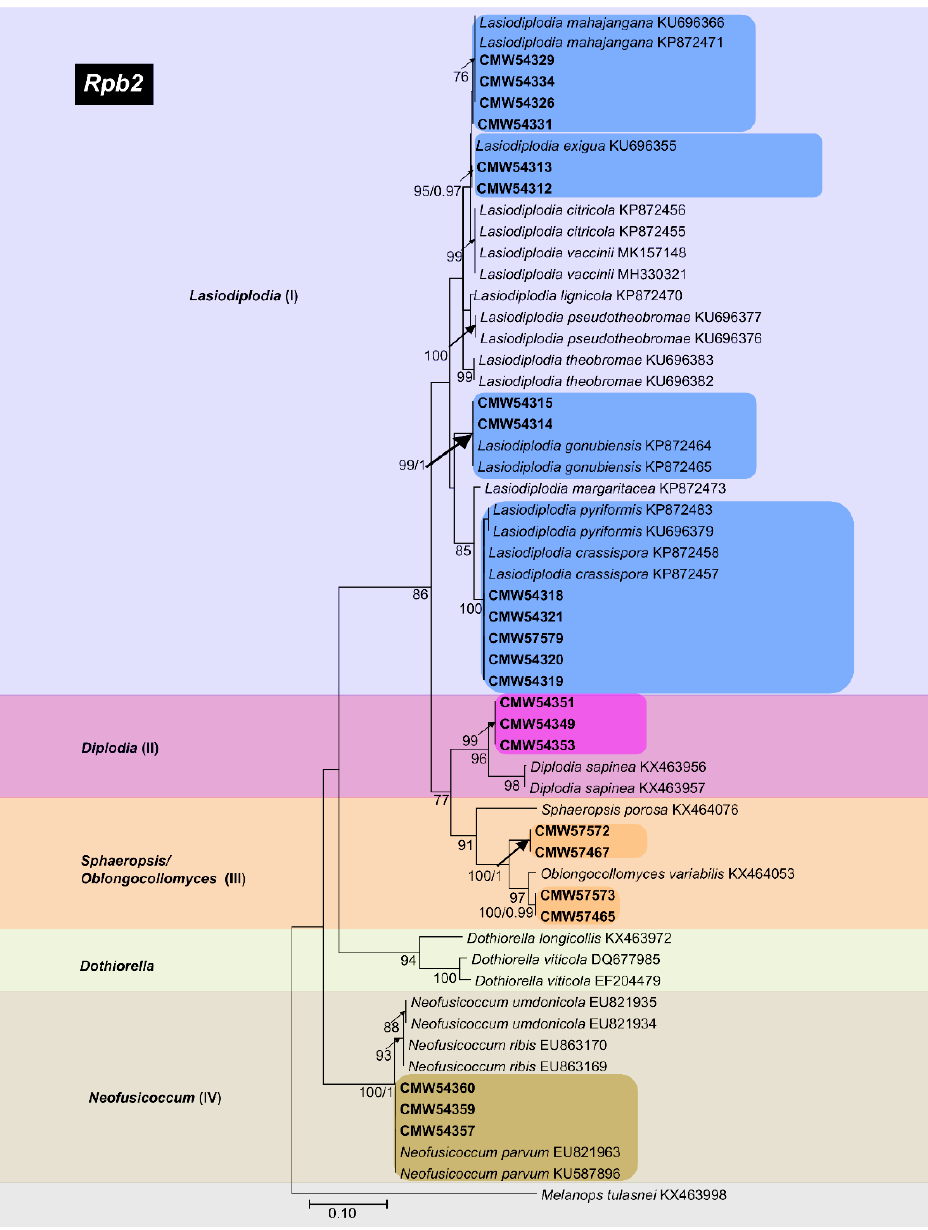
Figure 5. Maximum likelihood (ML) phylogenetic tree based on analyses of the rpb2 dataset showing relationship between isolates obtained in this study (in bold) and species of Botryosphaeriaceae. Bootstrap values (>70%) and PP values (>0.95) appear at the nodes. The tree was rooted to isolates of Melanops tulasnei.